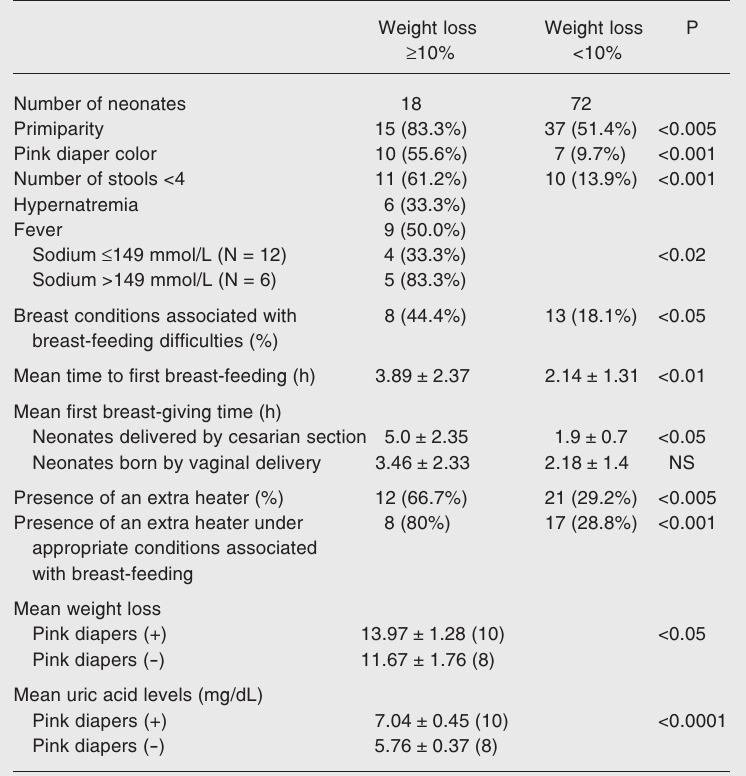
Table 1. Maternal and neonatal features of infants with a loss ≥ 10% and <10% of birth